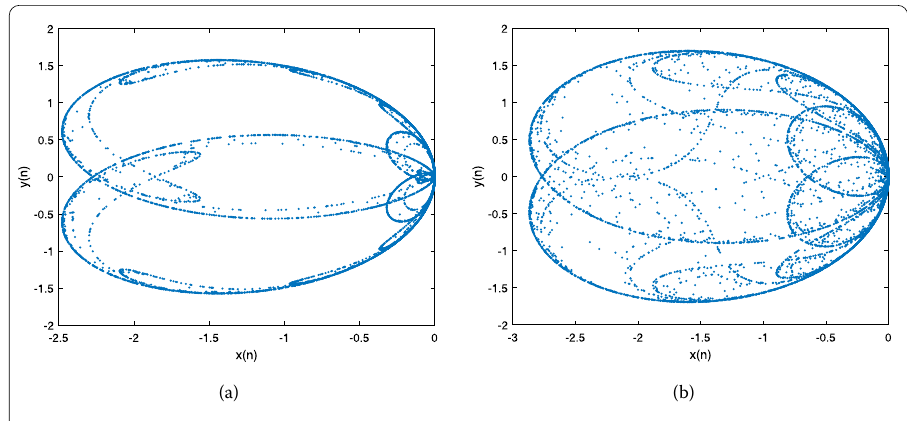
Figure 1 Chaotic attractor. The chaotic attractor when ( a ) b = 0.83, ( b ) b = 0.88,